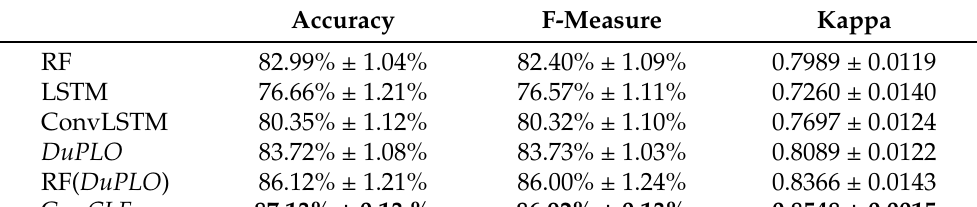
Table 3. Accuracy, F-Measure and Kappa of Cop CLF with regard to the competitor’s algorithms reported in [18]. The results were obtained through the average of ten different random splits. (Best results are in bold).